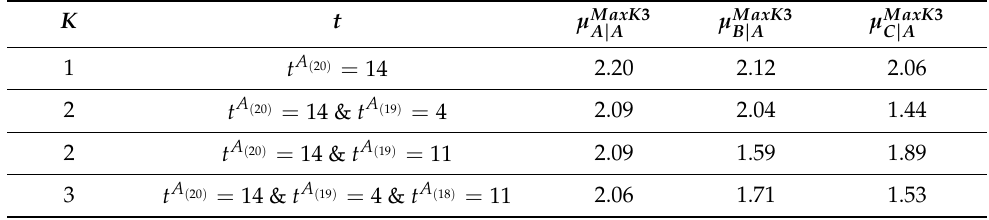
Table 1. The µ MaxK 3 indices for three time series A , B and C